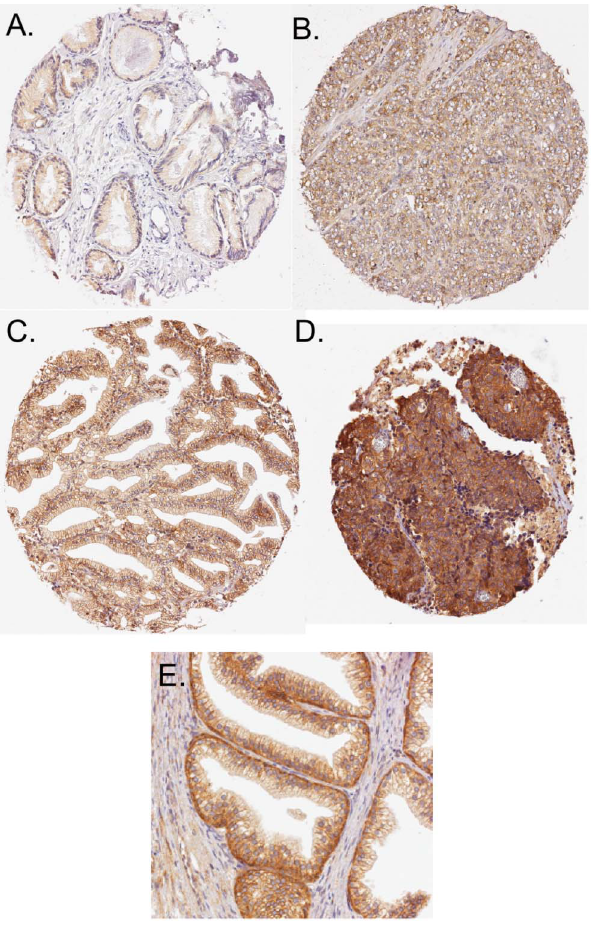
Figure 1. Examples of tissue microarray tumour cores with different ErbB2 immunoreactivities (A–D). The assigned scores were: Score 1 for Panel A; Score 2 for Panel B; Score 2.25 (75% intensity score 2, 25% intensity score 3) for Panel C; Score 4 for Panel D. The Gleason scores of the cases from which the cores were derived were 5 for Panels A and C, and 10 for Panels B and D. Panel E shows example of ErbB2 immunoreactivity in a non-malignant core, where basal and luminal staining could easily be